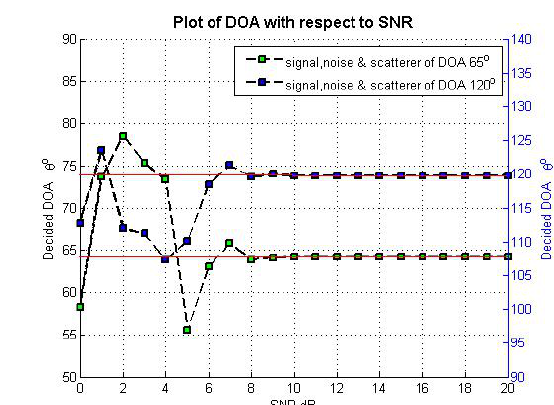
Figure 21: Convergence of decided DOA